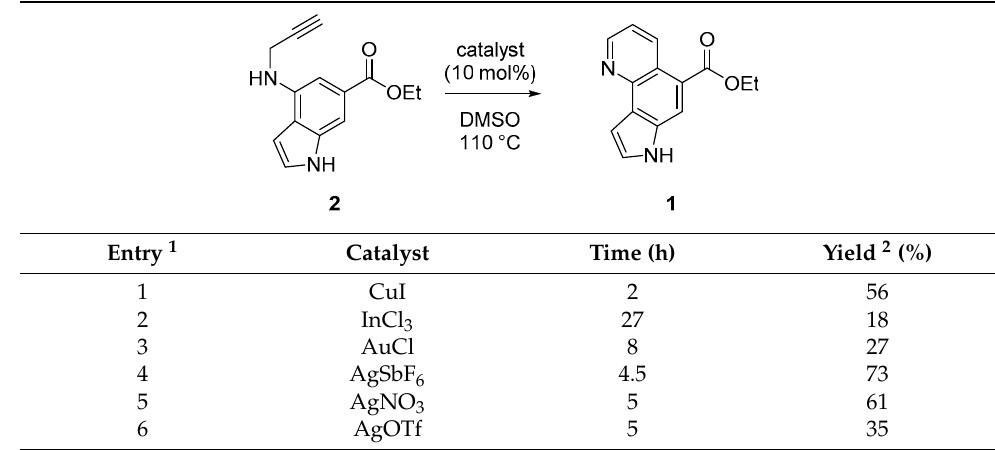
Table 1. Catalyst screening for the completion of synthesis of proposed structure of 1 .